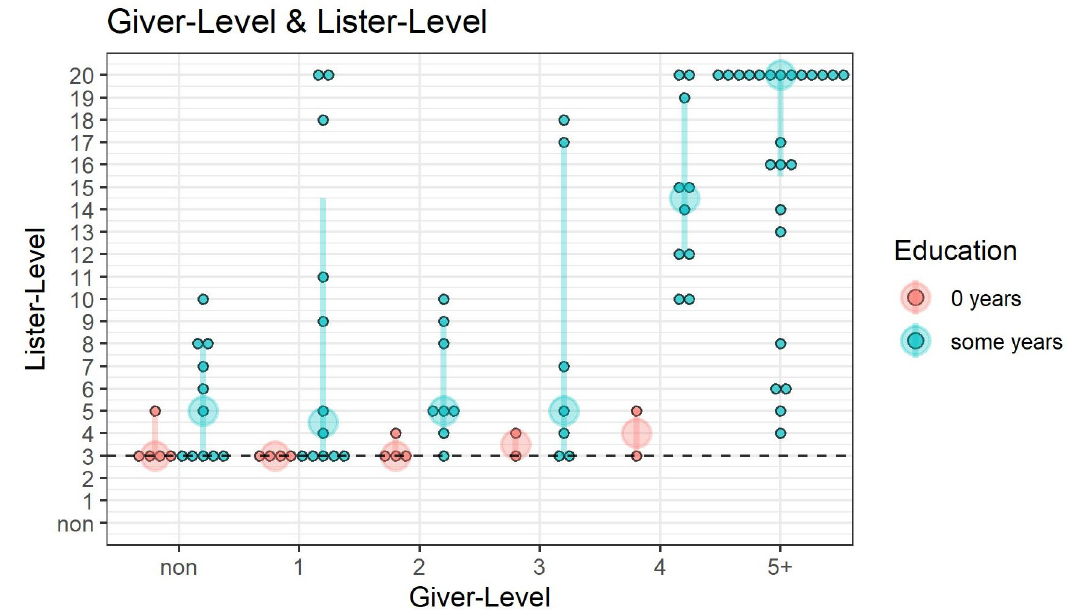
Fig 4. Lister-Level by Giver-Level. This shows that 4-Givers almost always have Lister-Levels above their Giver-Level, and non-, 1-, 2-, and 3-Givers mostly don’t do as well. Each small, black-bordered point represents an individual child. The larger, transparent red and teal dots represent the bootstrapped median Lister-Level corresponding to a particular Giver-Level and educational status (color- coded). https://doi.org/10.1371/journal.pone.0270739.g004 Fig 4 shows Lister-Level (y-axis) as a function of Giver-Level (x-axis). Bootstrapped median Lister-Levels for each Giver-Level are represented by the larger transparent dots (color-coded red and teal according to educational status) with 95% CI error bars. For 4-Givers (whose next step is to become Full-Counters), children’s Lister-Level is almost always higher than their Giver-Level. By the time children are succeeding on 4 on the Give-N task, they are able to list up to around 15 number words (with the exception of the two 4-Givers who have received no formal education). By the time they are succeeding on 5 and beyond on Give-N, they can typi- cally name around 17 or more number words. This indicates that children do tend to know more words than they are able to use in the Give-N task, at these higher knower-levels. We performed a regression to statistically evaluate the trends in Fig 4. The regression is dummy-coded, and treats the predictors of Giver-Level and Education (0/some years) as cate- gorical factors. The results of this regression in Table 1 show that 4-Givers reliably listed on